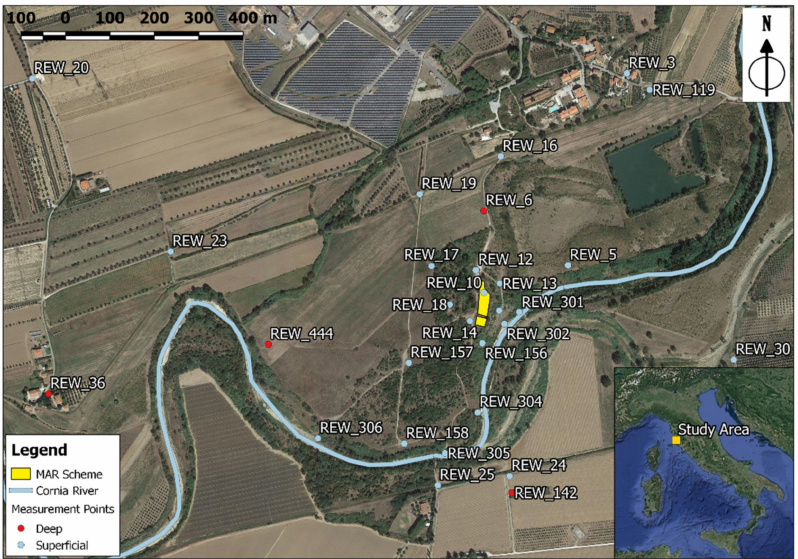
Figure 1. Study area location and measured